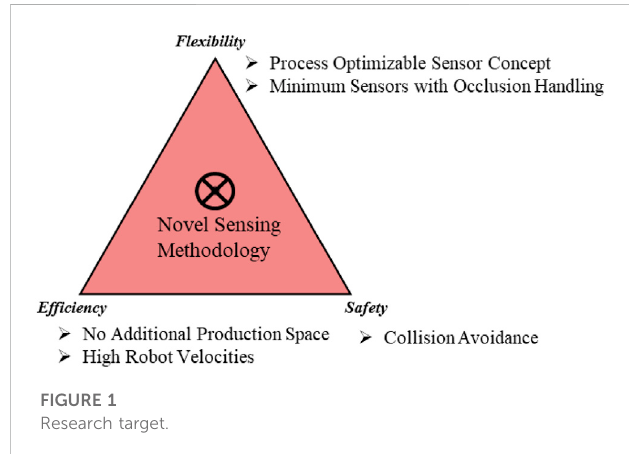
FIGURE 1 Research